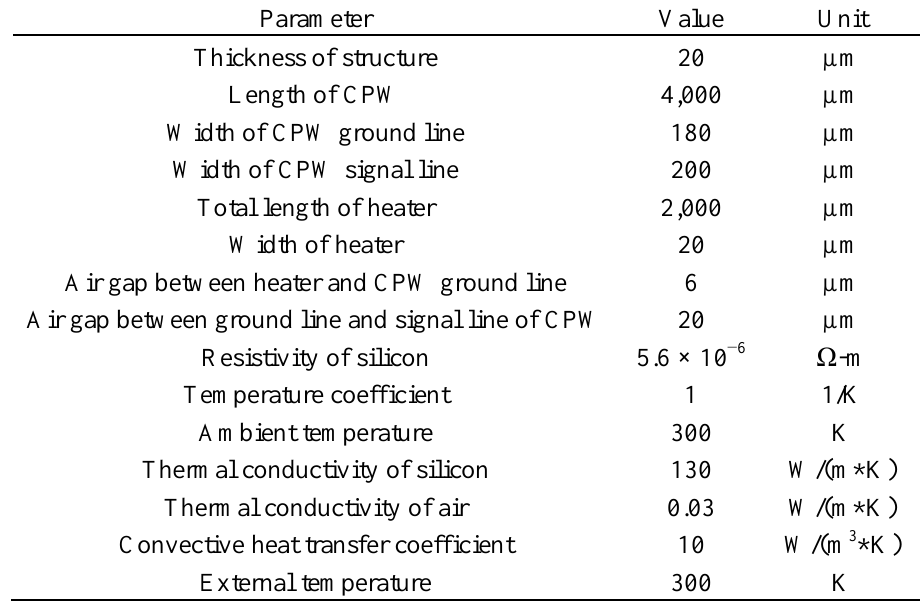
Table 1. Geometric and physical parameters in the